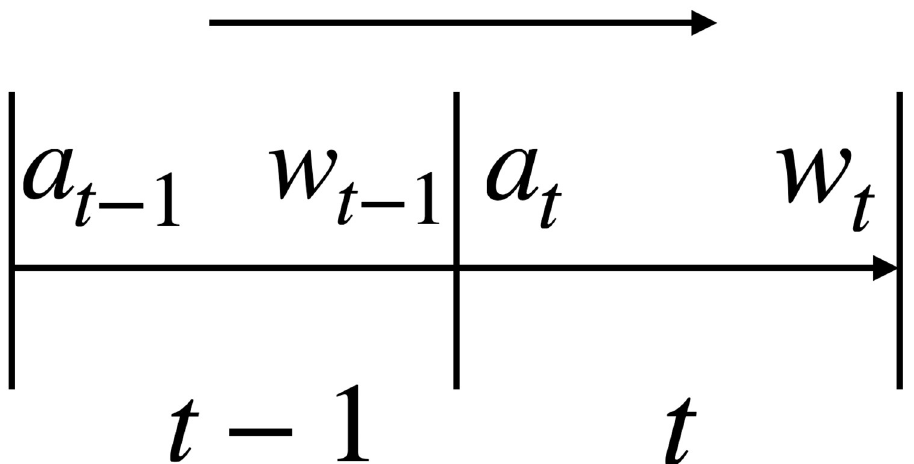
Fig 6. Transformed allocation weights due to the fluctuation in assets’